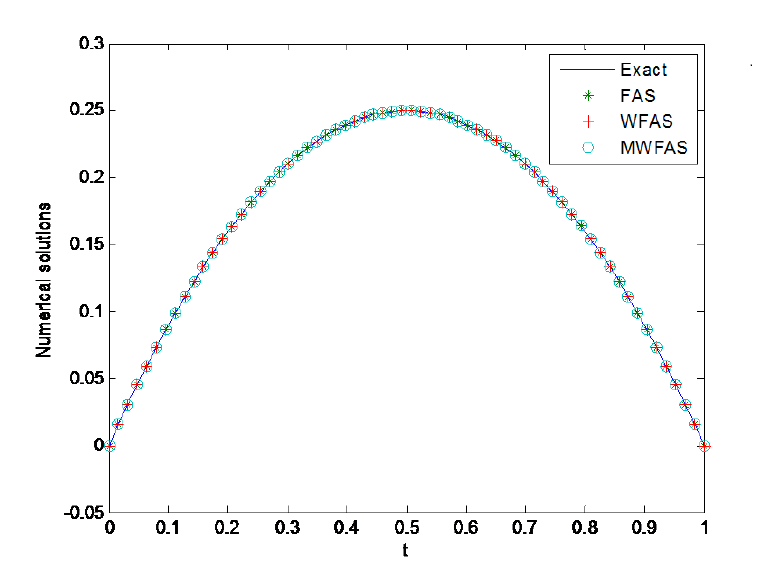
Fig. 1 Comparison of numerical solutions with exact solution of test problem 5.1, for N =64.